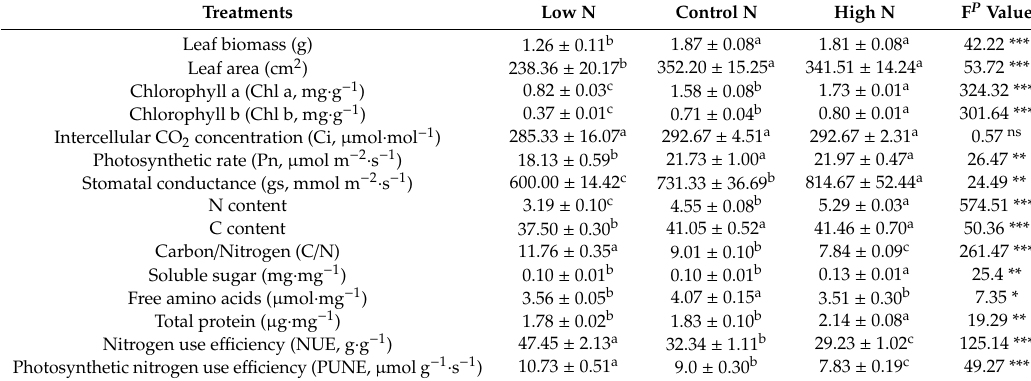
Table 1. Morphology, physiology, and growth response to low nitrogen and high nitrogen. Values labeled with di ff erent letters in same row indicate significant di ff erence between the nitrogen treatments. p Values of the ANOVAs are indicated. F P : F Valve P Value ; ns: No significant; * p < 0.05; ** p < 0.01; *** p <